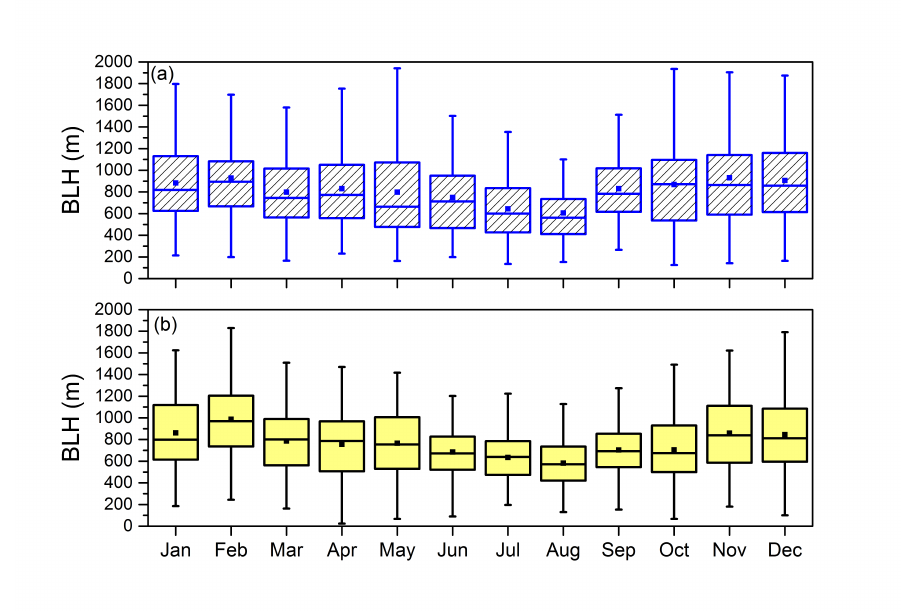
Figure 4. Seasonal variability of marine boundary layer height (BLH) from ( a ) radiosonde observations and ( b ) ECMWF IFS numerical weather prediction model for 2012 to 2017. The horizontal lines and the squares within the box represent the median and mean values, respectively, while the bottom and top of each box are the 25th and 75th percentiles. The whiskers are the 5th and 95th